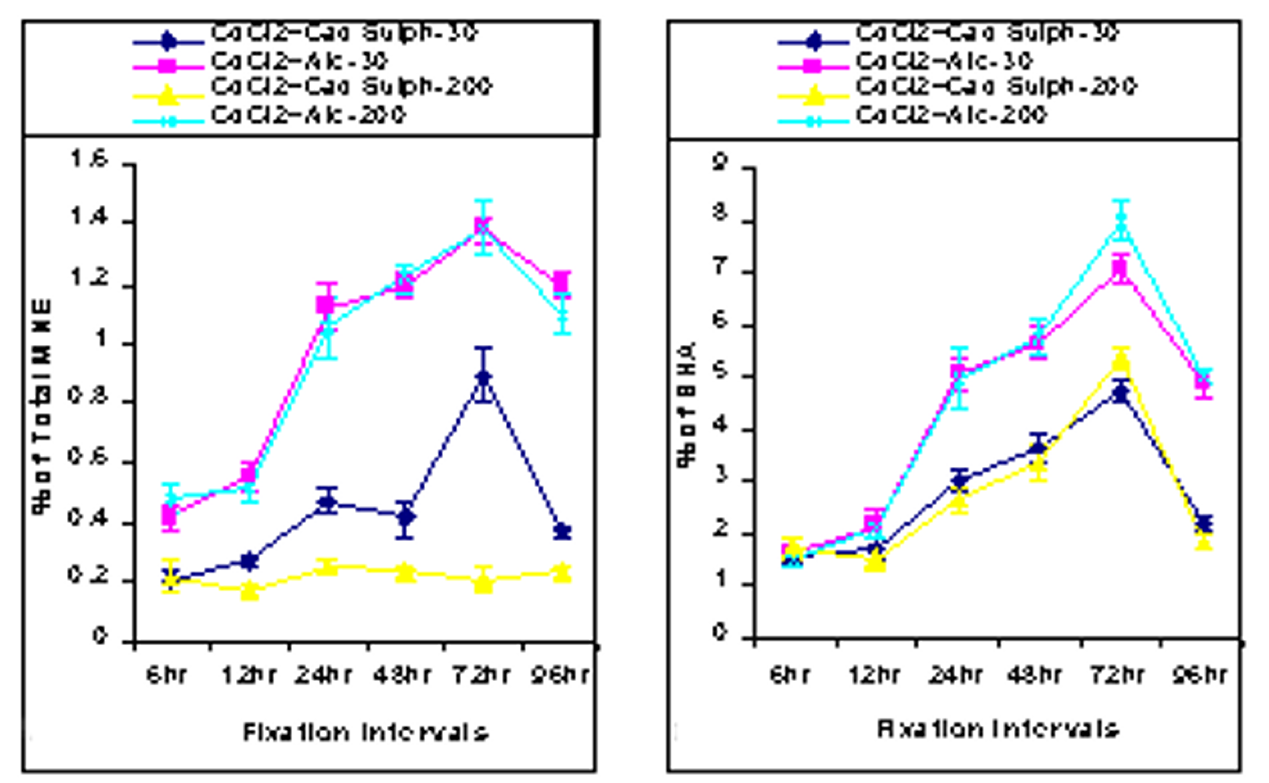
Figure 12 Showing time-dependent frequencies of Cad Sulph-30 com- bined pre- and post-fed and Cad Sulph-200 combined pre- and post-fed series versus their respective CdCl 2 treated alcohol-30 and alcohol-200 control mice. Chromosome aberration (CA)-9; Mitotic index (MI)-10; Micronucleated erythrocytes (MNE)-11 and Sperm head anomaly (SHA)-12.